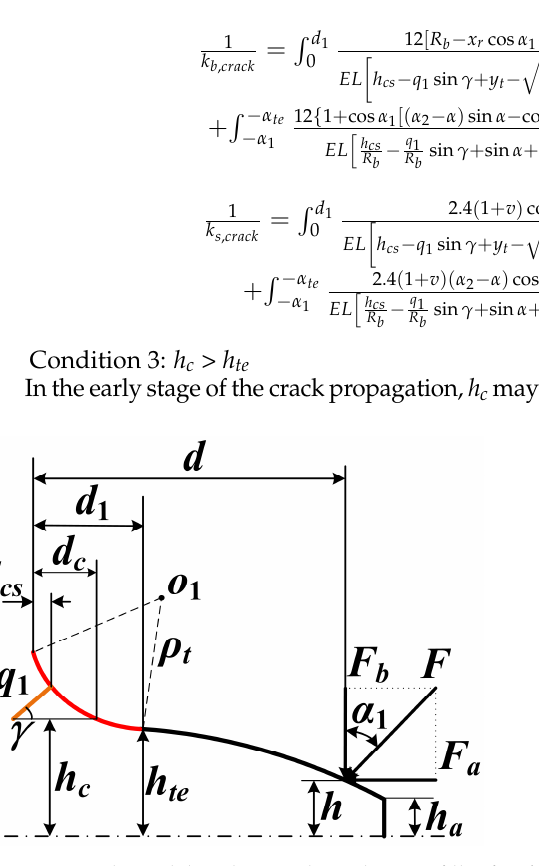
Figure 5. Tooth model with a crack on the root fillet for d cs < q 1 cos γ and h c > h te.